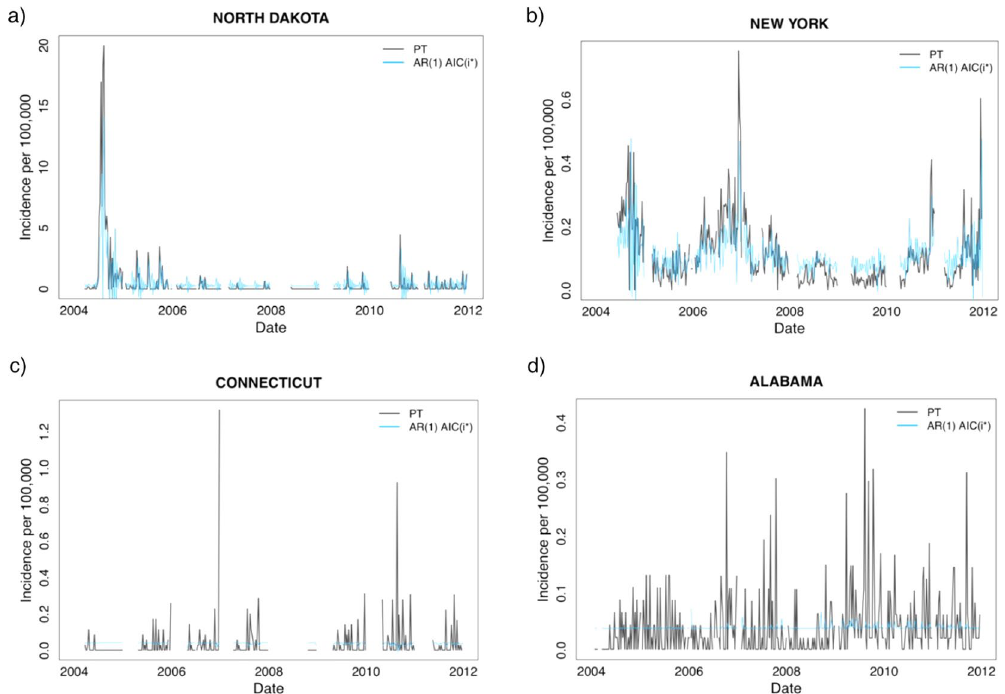
Figure 4. Time-series data showing recorded incidence from PT (black) and AR(1) AIC ( i (blue) for 2004–2011 for 2 states (North Dakota and New York) with well performing models in the top panels and 2 states (Connecticut and Alabama) with poorly performing models in the bottom panels. The variability between state-model accuracy suggests that GT surveillance approaches cannot be performed uniformly across regions of the